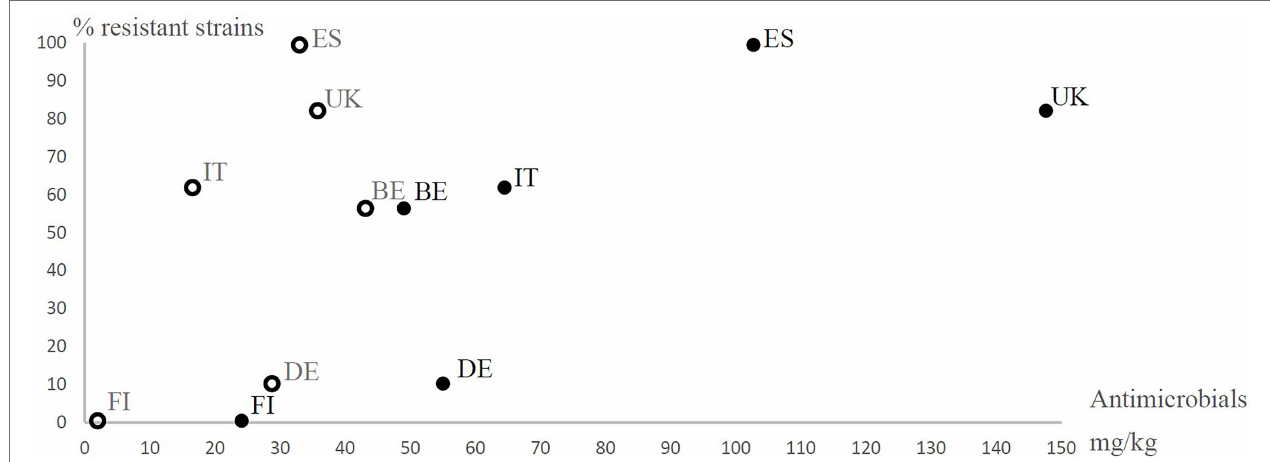
FIGURE 2 | Prevalence of antimicrobial resistant (resistant to at least one antimicrobial agent excluding ampicillin) Yersinia enterocolitica 4/O:3 strains in different European countries (BE, Belgium; DE, Germany; ES, Spain; FI, Finland; IT, Italy; and UK, United Kingdom) observed in the present study in relation to the estimated number of growth promoter antimicrobials used (open circles) and the therapeutic antimicrobials used (closed circles) for animals (mg/kg) in six European countries in the mid-1990s. The use of antimicrobial agents for animals in mg per kg was calculated from the estimated numbers of antimicrobial agents sold for the treatment of animals in 1997 and the estimated weights of slaughtered animals in 1996 in each country. The data are from European Agency for the Evaluation of Medicinal Products (EMEA) (1999). The data regarding Belgium include Luxemburg. In Finland, growth promoter antimicrobial levels were less than 2 mg/kg, but 2 mg/kg was used for the